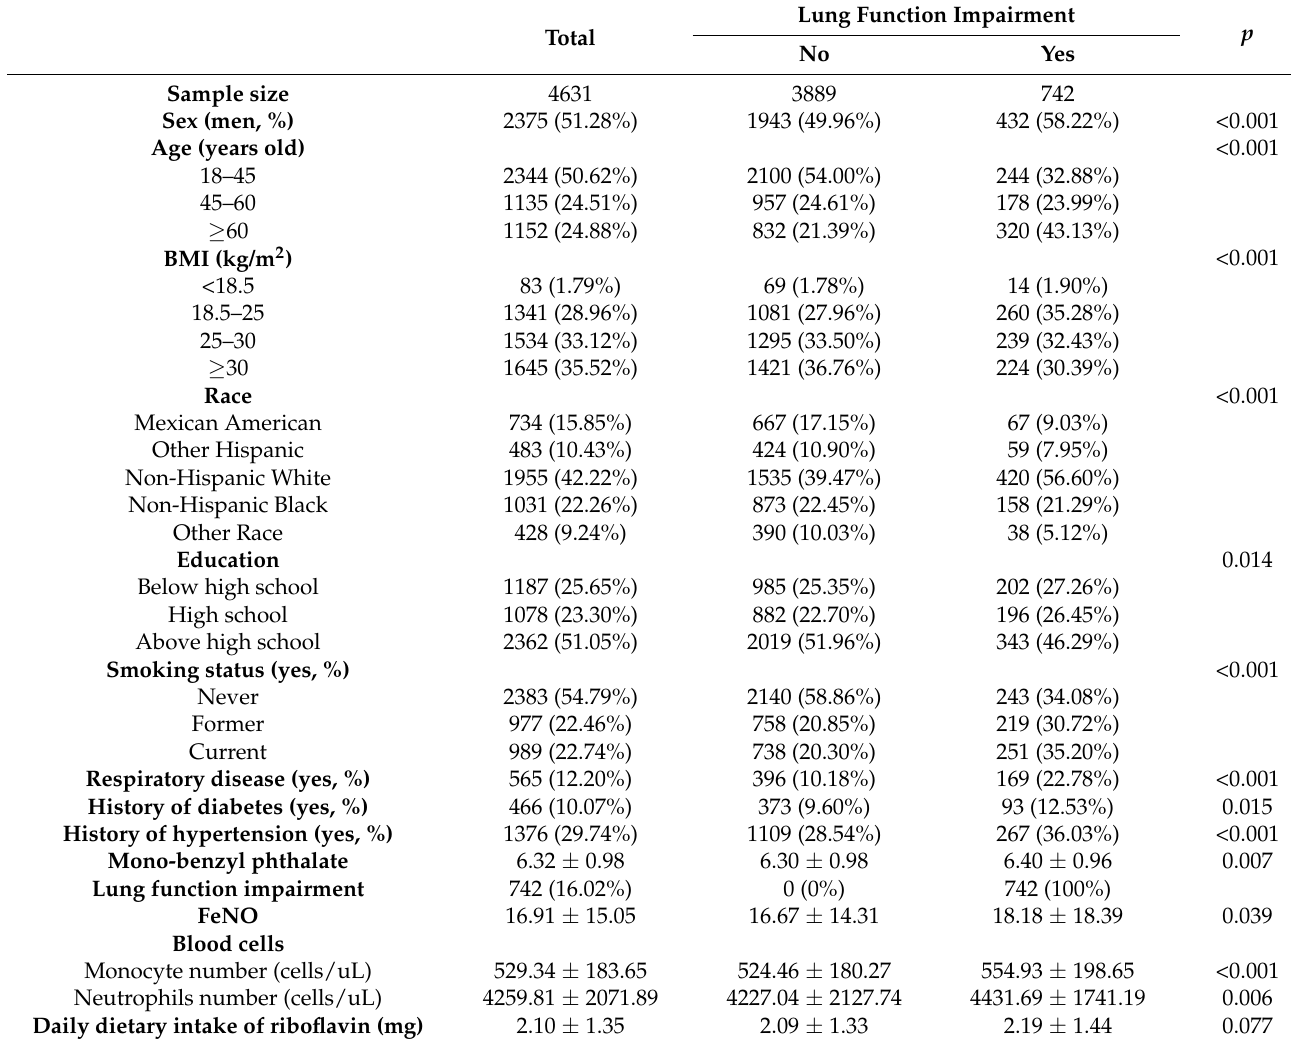
Table 1. The characteristics of study population and the difference between groups with and without lung function